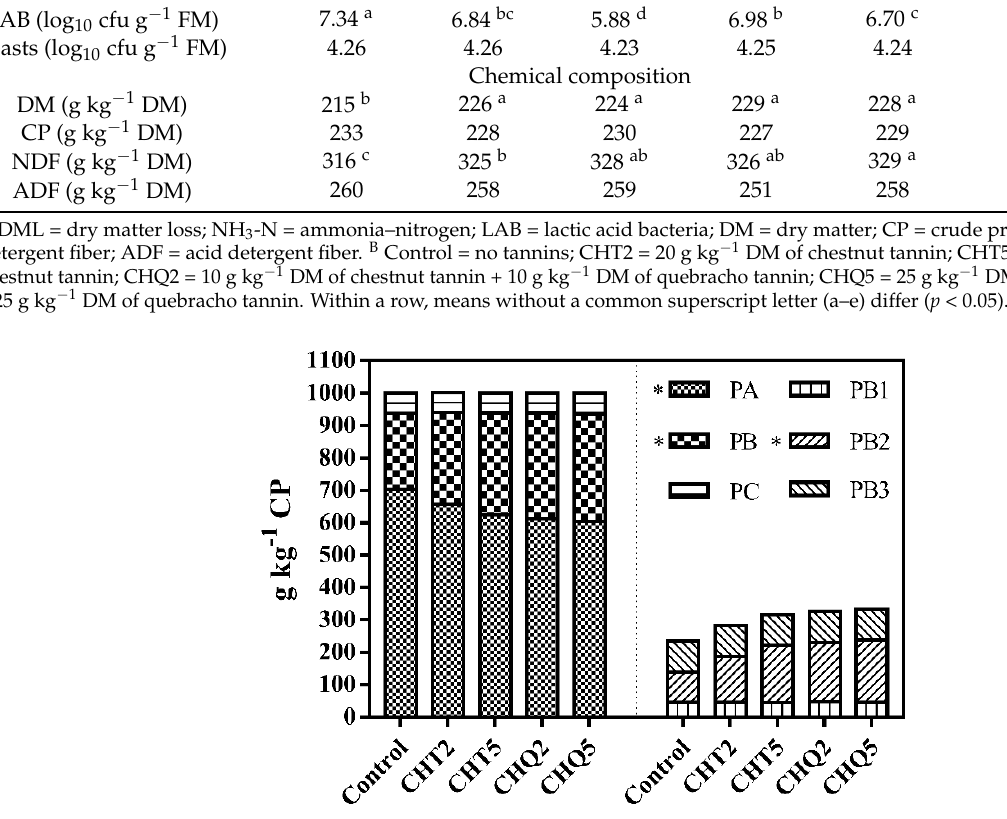
Figure 1. The effects of tannin treatments on protein fractions of alfalfa silage. Control = no additives; CHT2 = 20 g kg − 1 DM of chestnut tannin; CHT5 = 50 g kg − 1 DM of chestnut tannin; CHQ2 = 10 g kg − 1 DM of gallnut tannin + 10 g kg − 1 DM of quebracho tannin; CHQ5 = 25 g kg − 1 DM of gallnut tannin + 25 g kg − 1 DM of quebracho tannin. PA = non-protein nitrogen; PB = true protein; PB 1 = rapid degradation of true protein; PB 2 = intermediate degradation of true protein; PB 3 = slow degradation of true protein; PC = undegradable protein. * represents significant difference at p < 0.05.